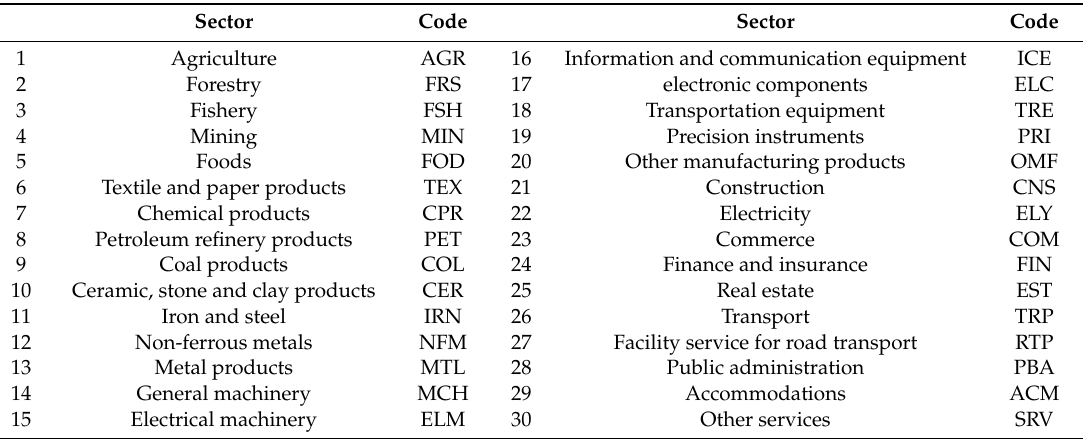
Figure 3. Structure of exports and imports .